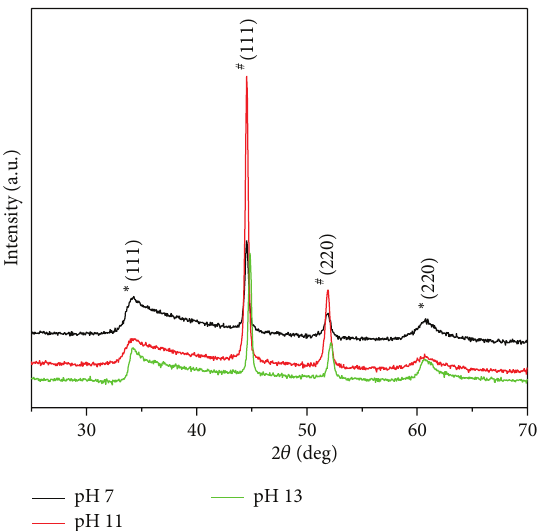
Figure 3: Effect of pH on particle size of catalyst.